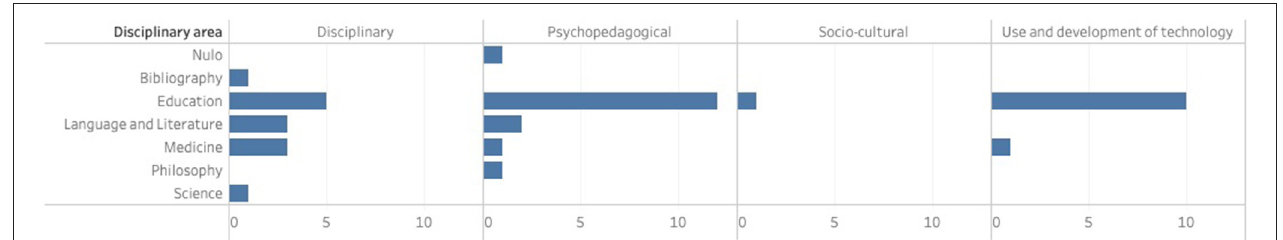
FIGURE 2 | Theoretical–conceptual trends in educational innovation